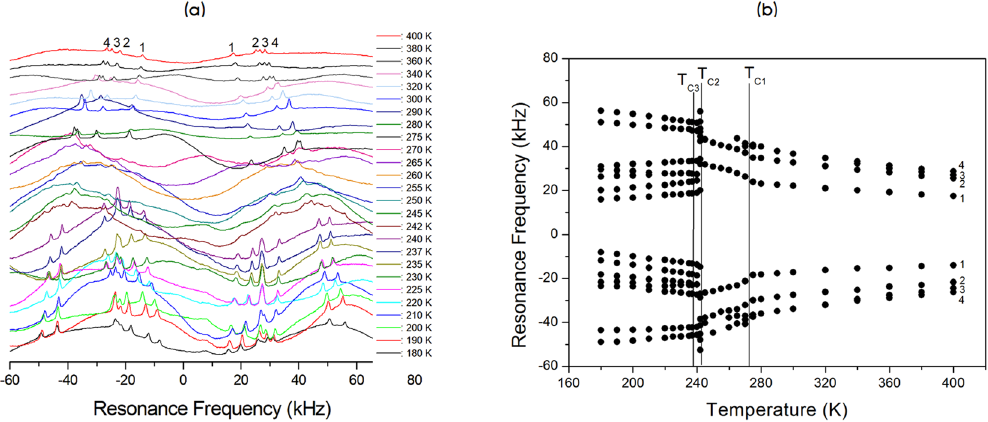
Figure 11. ( a ) In-situ 14 N NMR spectrum as a function of temperature for [N(CH 3 ) 4 ] 2 Zn 1- x Cu x Br 4 ( x = 1). ( b ) Resonance frequency of 14 N NMR spectrum as a function of temperature for [N(CH 3 ) 4 ] 2 Zn 1- x Cu x Br 4 ( x =